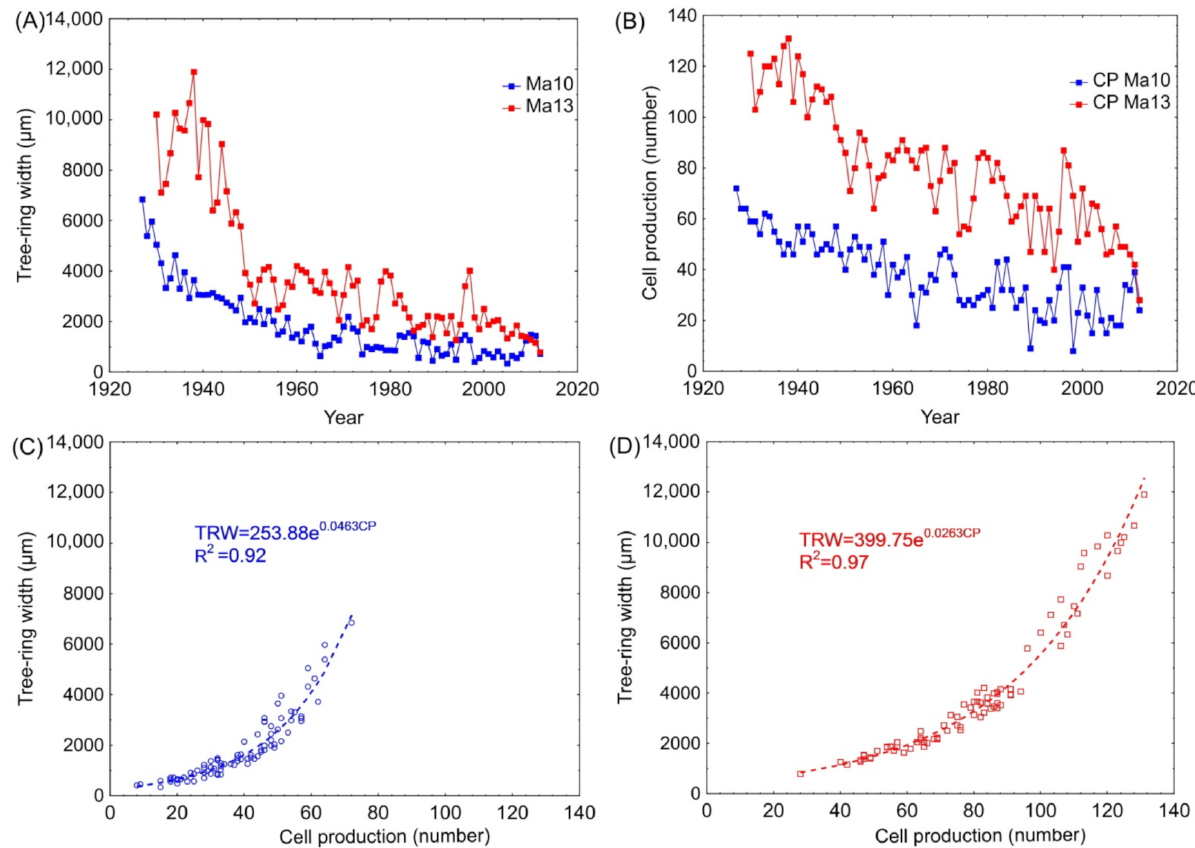
Figure 8. Variations of tree-ring width (TRW) for the trees Ma10 (blue curve) and Ma13 (red curve), 1925 − 2012. ( A ); variations of cumulative cell production (CP) for the trees Ma10 (blue curve) and Ma13 (red curve), 1925 − 2012 ( B ); scatterplot between CP and TRW and respective exponential regression for Ma10 ( C ); scatterplot between CP and TRW and respective exponential regression for Ma13 ( D